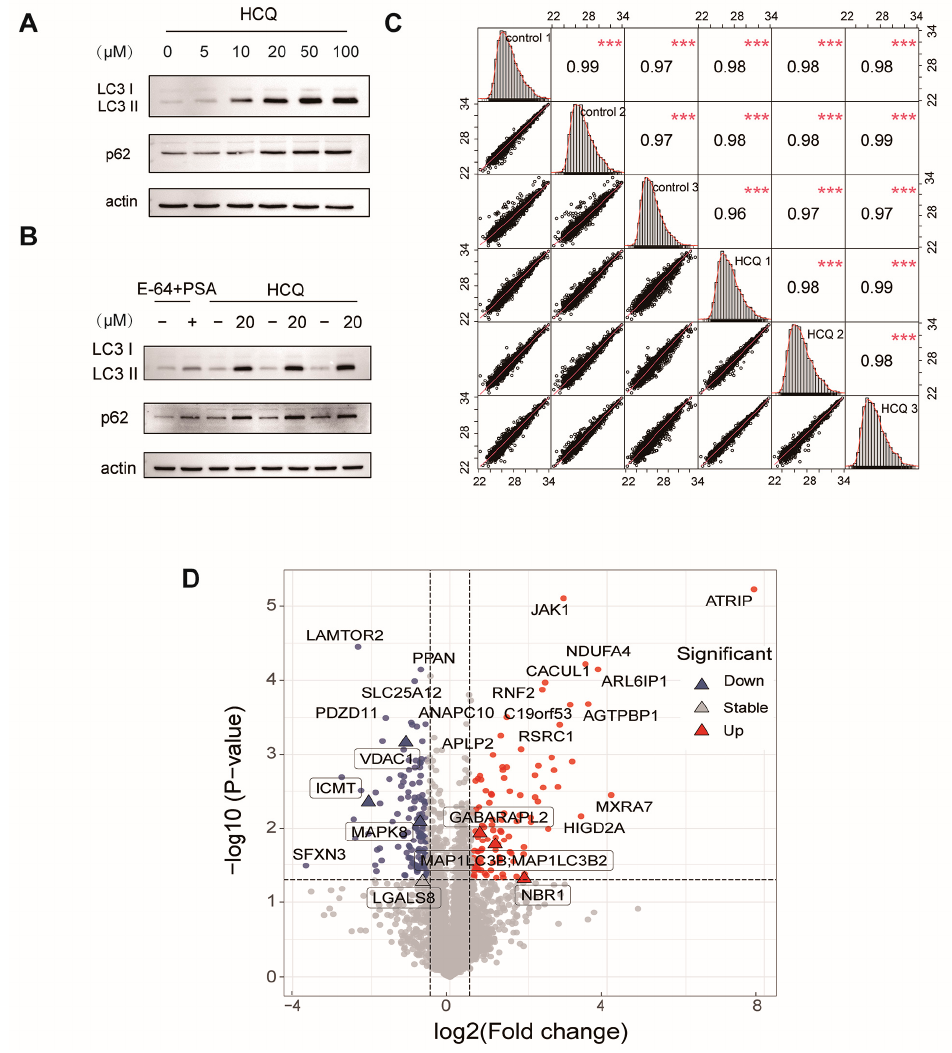
Figure 2. The influence of HCQ on the proteome. ( A ) HCQ inhibited autophagy dose-dependently. ( B ) Autophagy was well blocked in each replicate for the quantitative proteomics study. ( C ) The correlation between the three replicates (***, p < 0.001). ( D ) The volcano map showed the protein dynamics in response to HCQ treatment. Gray: unchanged proteins; red: upregulated proteins; blue: downregulated proteins.